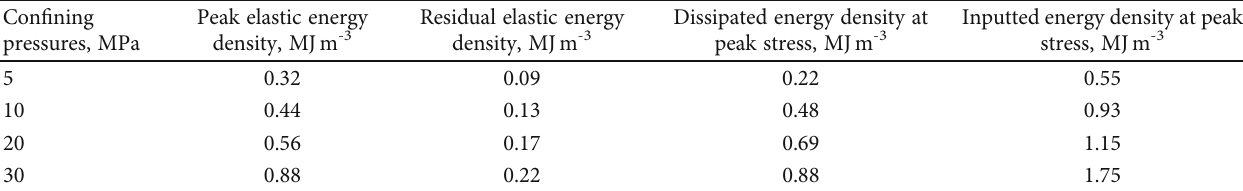
Figure 11: Energy ratio evolution curves of elastic energy and damage dissipated energy under di ff erent con fi ning pressures ((a) 5MPa, (b) 10MPa, (c) 20MPa, and (d) 30 MPa). Table 3: Characteristic values of rock energy under di ff erent con fi ning